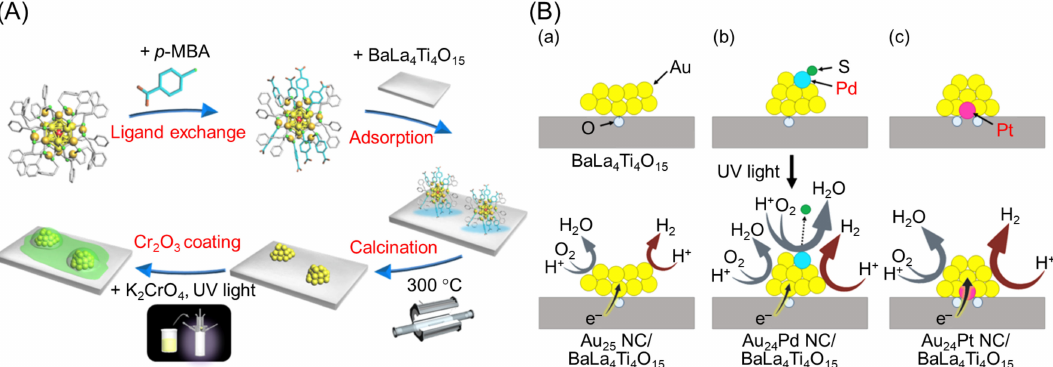
Figure 22. ( A ) Schematic illustration of the experimental procedure for the preparation of Au 24 M NC/BaLa 4 Ti 4 O 15 (M = Au, Pd, or Pt). p -MBA; 4-mercaptobenzoic acid. ( B ) Proposed structures of Au 24 M NC/BaLa 4 Ti 4 O 15 , where M is ( a ) Au, ( b ) Pd, and ( c ) Pt before (above) and during (below) the water-splitting reaction. Reproduced with permission from reference [76]. Copyright 2019 American Chemical